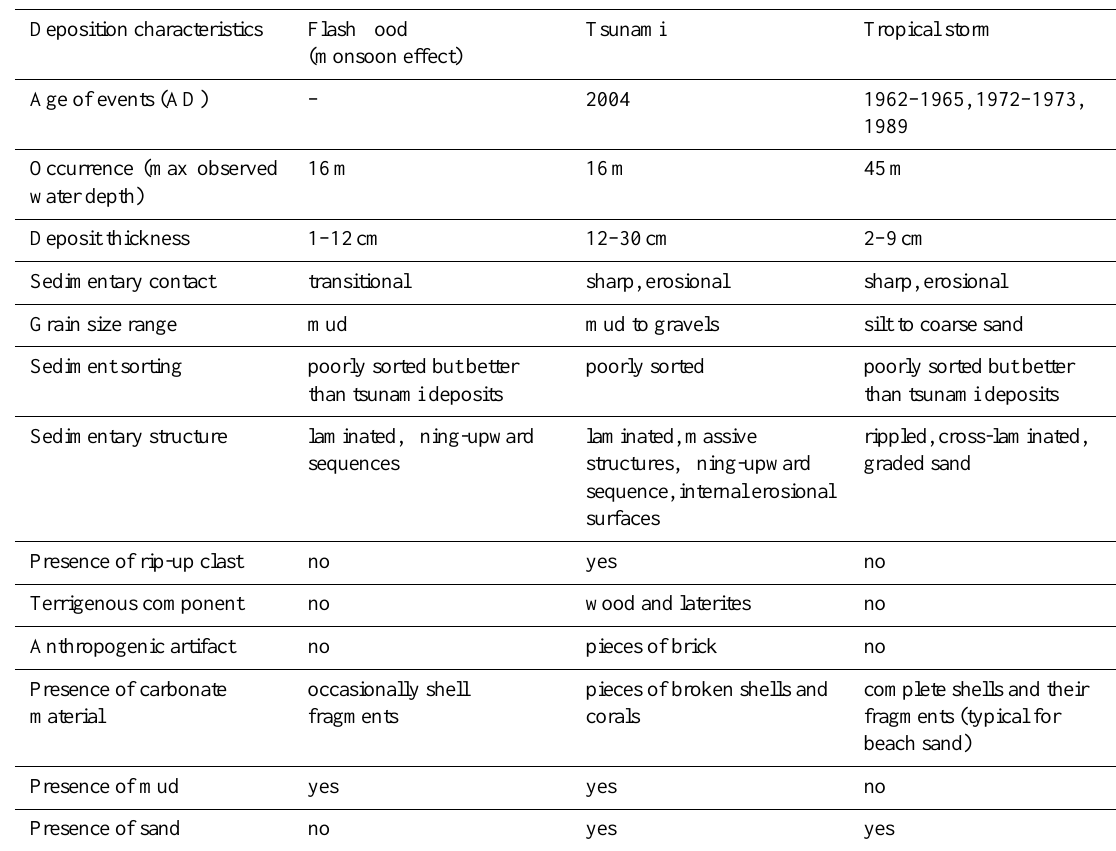
Table 5. Differences between the sedimentary features of flash-flood, tsunami and storm deposits on the Andaman Sea shelf. Deposition